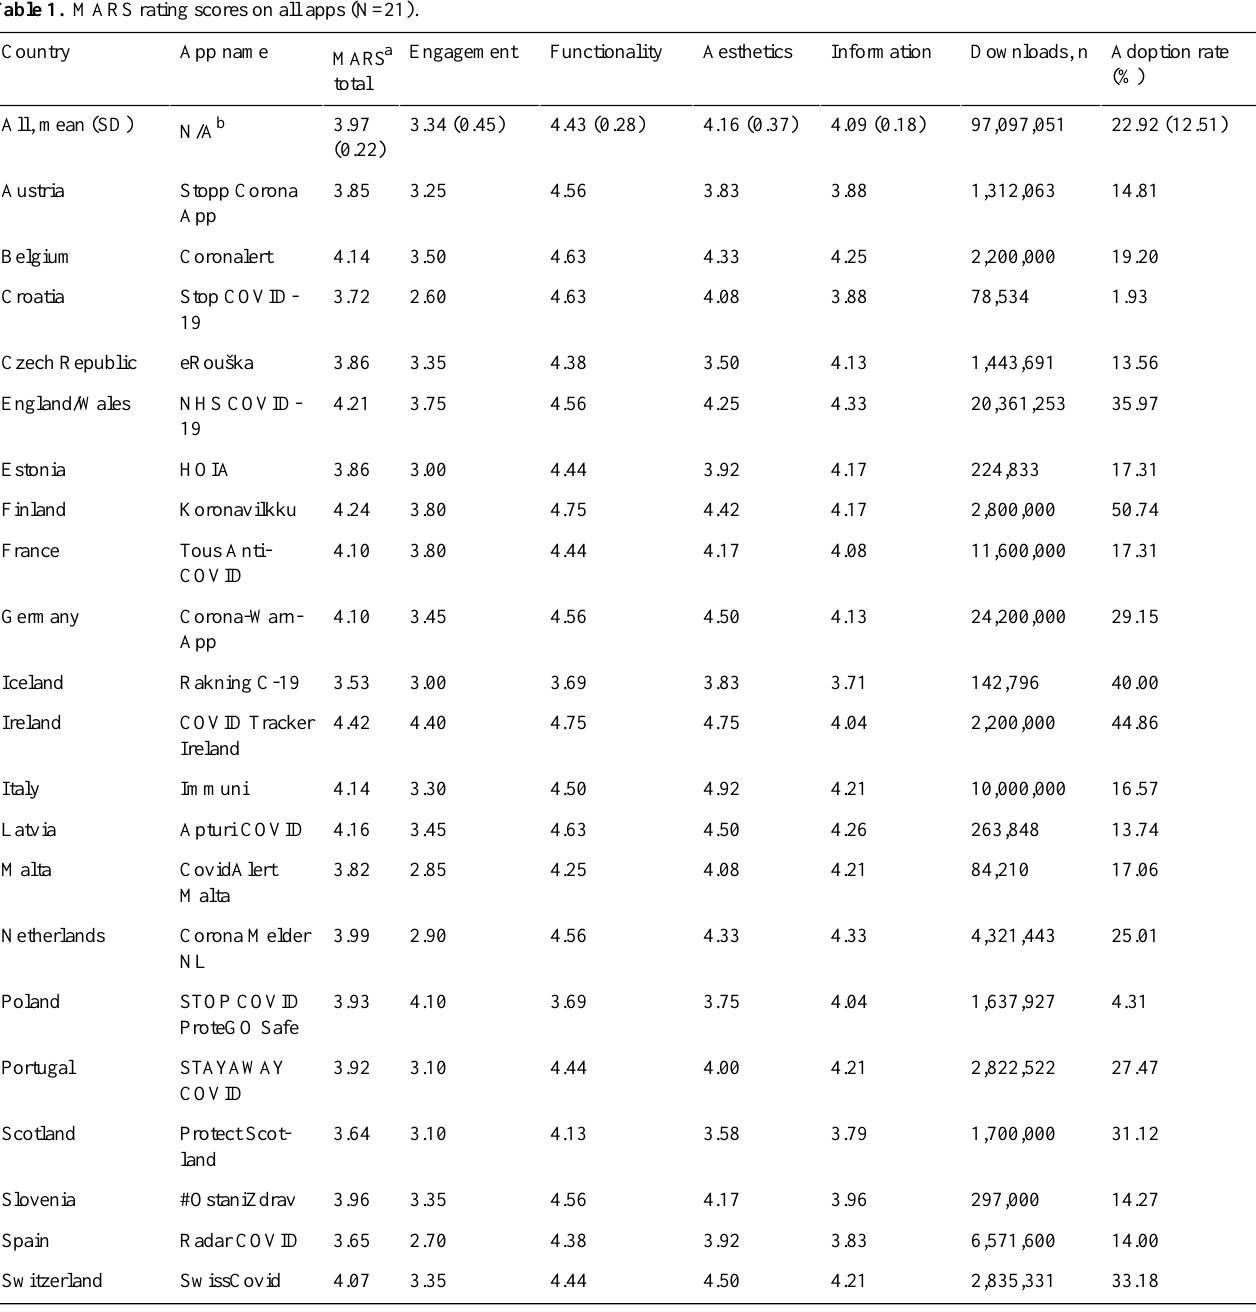
Table 1. MARS rating scores on all apps